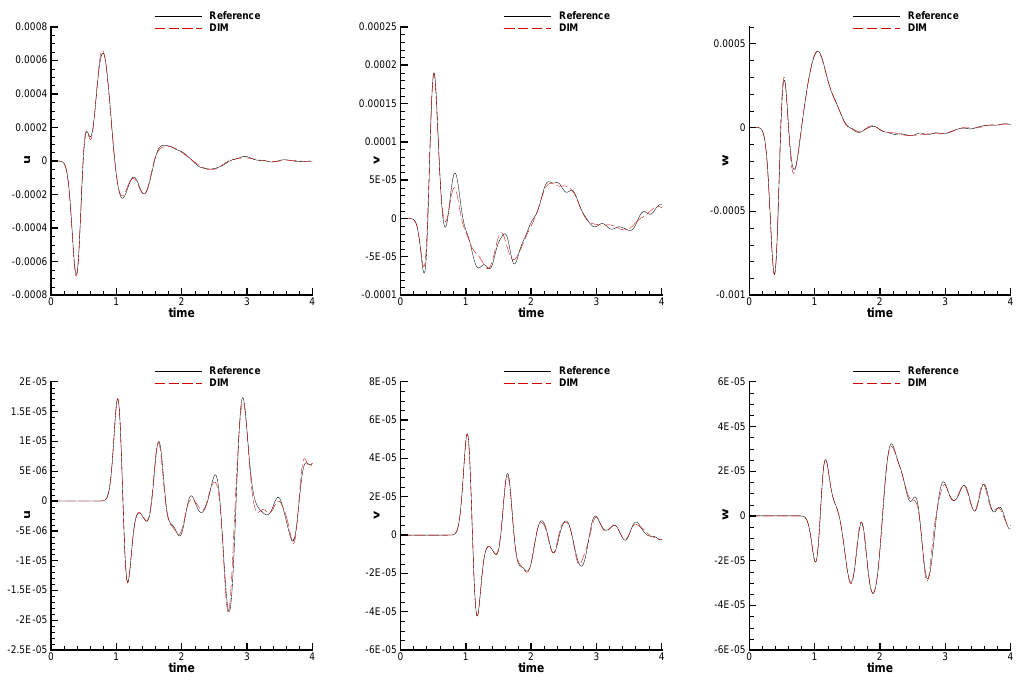
Figure 3. Seismogram recordings in two observation points obtained with the diffuse interface approach on adaptive Cartesian meshes [118] and with a reference solution obtained with high order ADER-DG schemes on boundary-fitted unstructured meshes